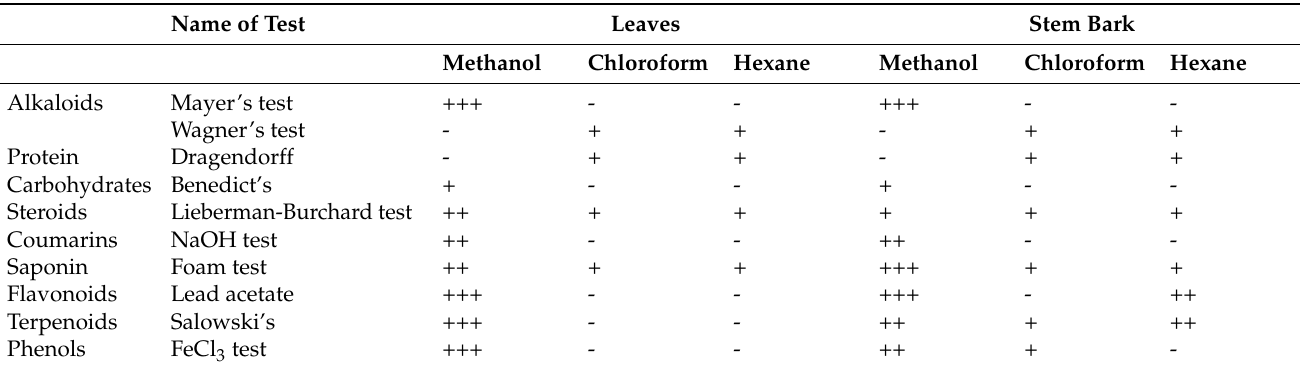
Table 2. Phytochemical screening of the methanol, chloroform, and hexane extracts of both the leaves and stem bark of D. villosa .